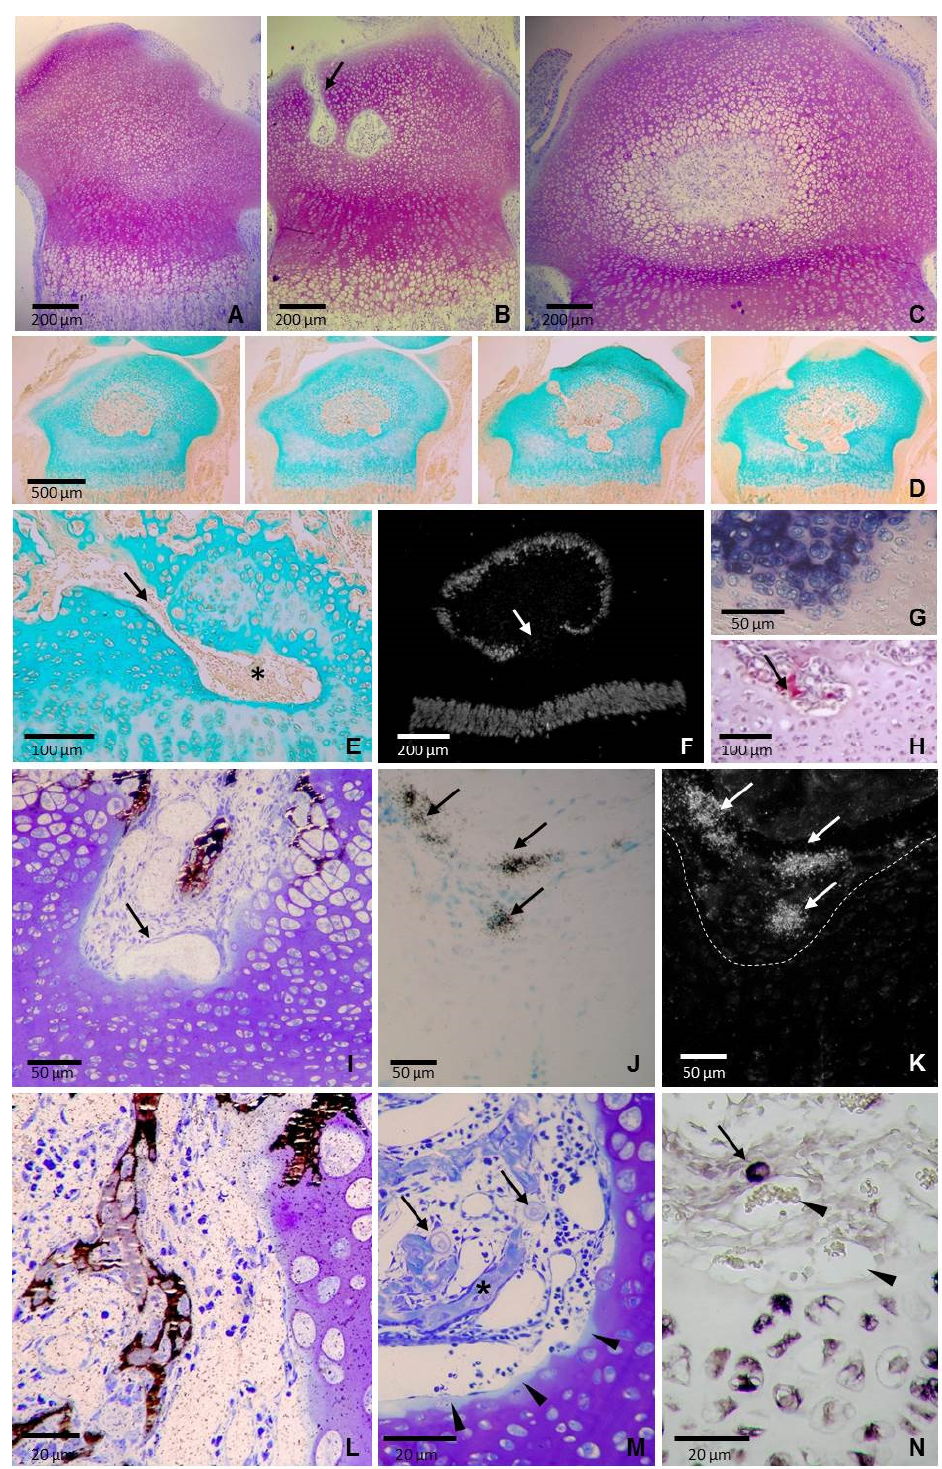
Figure 1. Sections of the tibial epiphysis at the beginning of epiphyseal bone formation. ( A ) Semithin section stained with toluidine of a 3-day-old tibia showing a completely cartilaginous epiphysis. ( B ) Semithin section stained with toluidine of an 8-day-old tibia showing a cartilage canal (arrow) and the early secondary ossification center. ( C ) Semithin section stained with toluidine of an 11-day-old tibia showing a central rounded marrow cavity smoothly bordered by hypertrophic cartilage. ( D ) Series of consecutive paraffin sections of a 14-day-old tibia stained with Alcian blue. The border of the epiphyseal marrow cavity is smooth at the upper and lateral portions and rugged in the lower portion. ( E ) A tongue or finger-like extension of marrow tissue (arrow) deeply penetrating into the epiphyseal cartilage of a 14-day-old tibia (asterisk). ( F ) Dark field microscopy of mRNA expression pattern of type X collagen of a 14-day-old tibia. Expression is found in chondrocytes of both the metaphyseal growth plate and the upper portion of the epi- physeal cartilage but no expression is found in the central region of the lower epiphyseal cartilage (arrow). ( G ) Alkaline phosphatase activity and ( H ) TRAP-positive cells (arrow) in a tongue of ep- iphyseal marrow tissue penetrating into the epiphyseal cartilage of a 14-day-old tibia. ( I ) A miner- alized area adjacent to capillaries in a tongue of epiphyseal marrow tissue of a 14-day-old tibia stained with von Kossa and counterstained with toluidine blue (arrow). ( J ) Bright field and ( K ) dark field images of a section of a 14-day-old tibia hybridized with a 35 S-labeled riboprobe for os- teocalcin. Expressión is observed in some scattered cells (arrows) separated from the border of the cartilage (dotted white line). ( L ) Section of a of a 14-day-old tibia showing von Kossa positive cells located at the mid-depth zone of a finger-like extension of the marrow tissue. Cells are located in